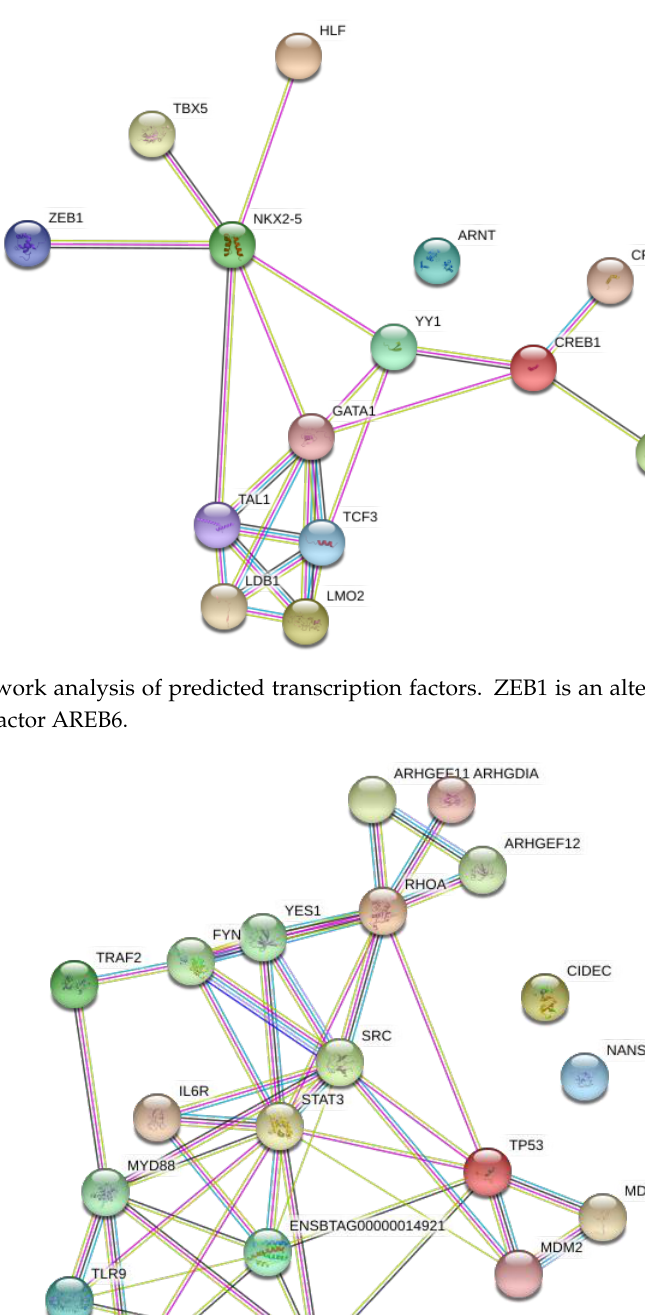
Figure 5. Network analysis of predicted genes and transcription factors. ZEB1 is an alternative name for transcription factor AREB6. (Edge color legend; blue: from curated database, pink: experimentally determined, green: textmining, brown: co-expression).